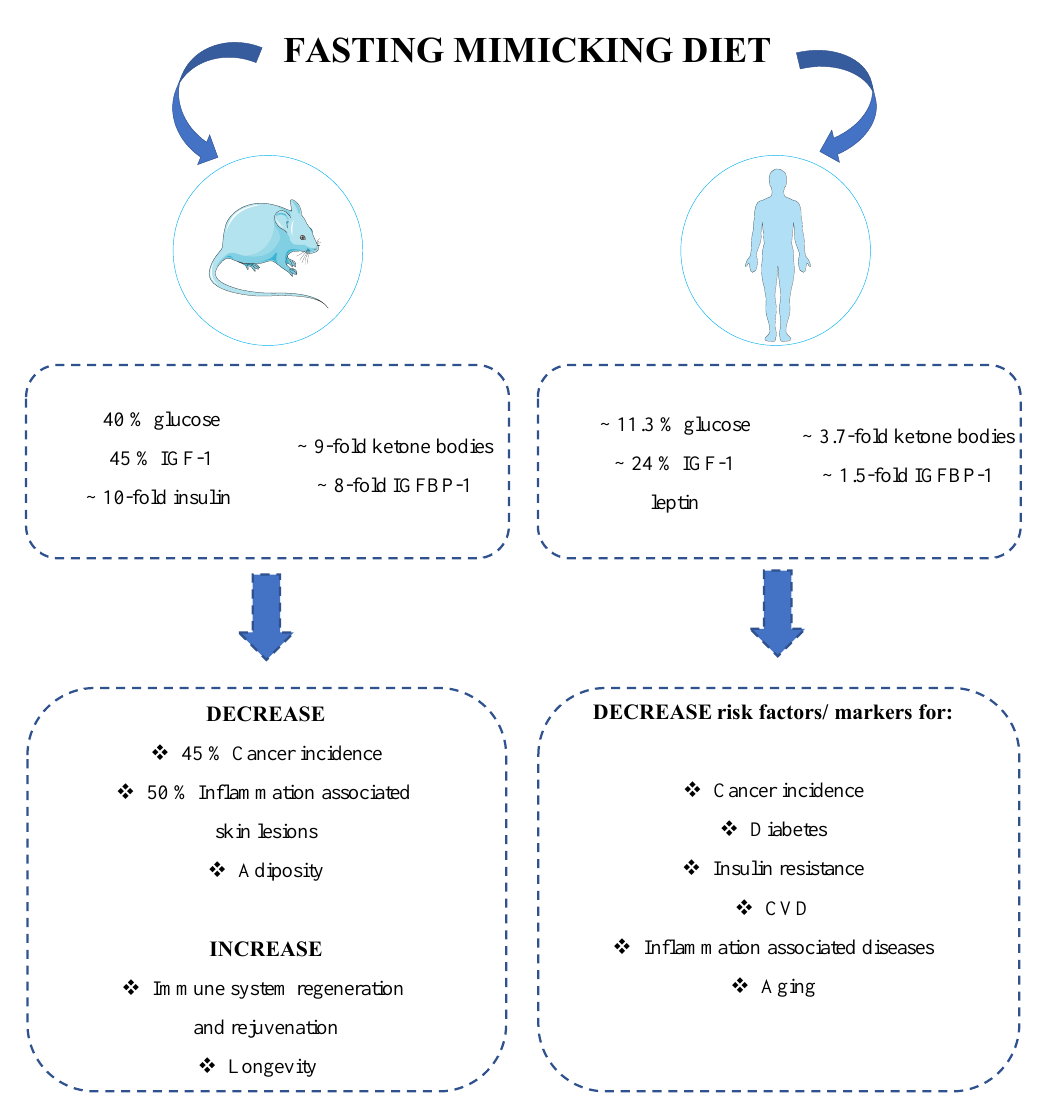
Figure 3. A periodic diet that mimics fasting promotes longevity and reduces risk factors involved in age-related diseases. The fasting mimicking diet (FMD) is characterized by low proteins and sugars and relatively high unsaturated fats. This dietary regimen is able to mimic the metabolic changes induced by water-only fasting while lowering the burden and risk for side effects [112,140]. Preclinical studies show that periodic cycles of FMD can significantly reduce blood glucose, IGF-1, leptin and insulin levels in mice, while increasing ketone bodies production and IGFBP-1 levels. These metabolic changes promote immune system regeneration and rejuvenation while reducing neoplasia incidence by 45%, inflammation associated skin lesions by 50% and obesity [112]. Analogously to rodents, also in humans, periodic FMD decreases blood glucose, insulin, IGF-1, and leptin levels while increasing ketone bodies and IGFBP-1, metabolic changes partially maintained even after the refeeding period [112,140]. These FMD-dependent effects are of particular interest given their key role in age-related diseases, especially cancer and metabolic disorders. Taken together, these data indicate that periodic cycles of FMD could prevent obesity and reduce cancer risk in humans, as suggested by results obtained in preclinical trials [112].